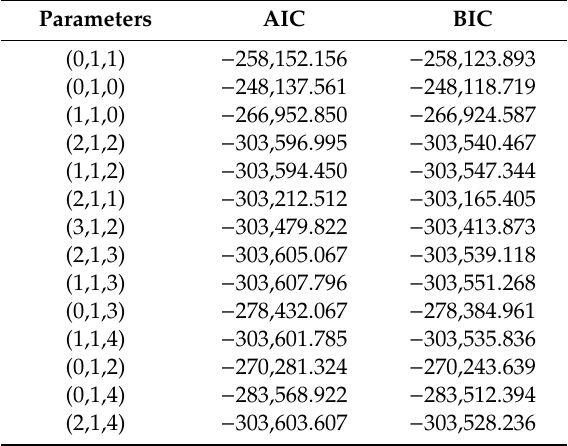
Table 1. Autoregressive integrated moving average (ARIMA) parameter selection results.